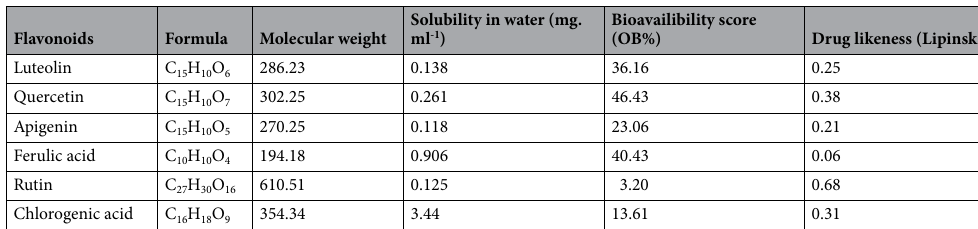
Table 1. Physicochemical properties and Drug likeness of studied flavonoids.